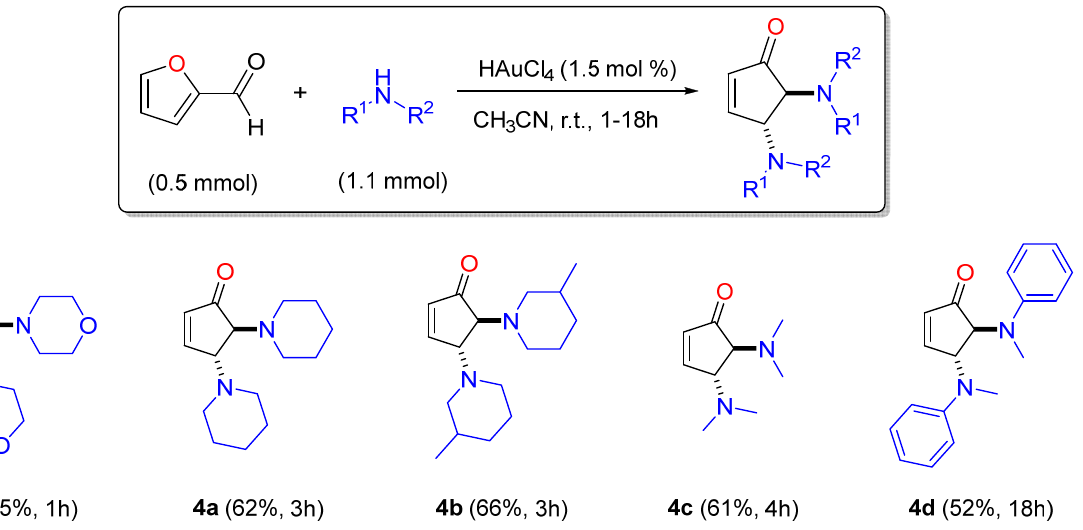
Scheme 2. Synthetic application for the substituted trans -DACPs ( 4 , 4a – 4d ) formation from the re- action of 1 and secondary amines mediated by the presence of HAuCl